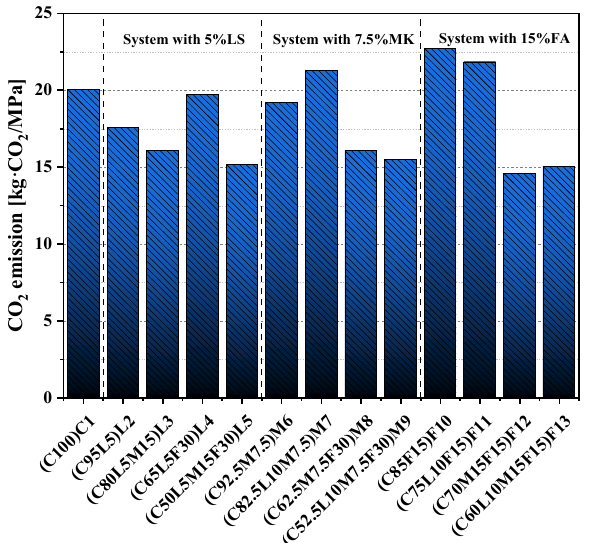
Figure 13. CO 2 emissions per unit of compressive strength.